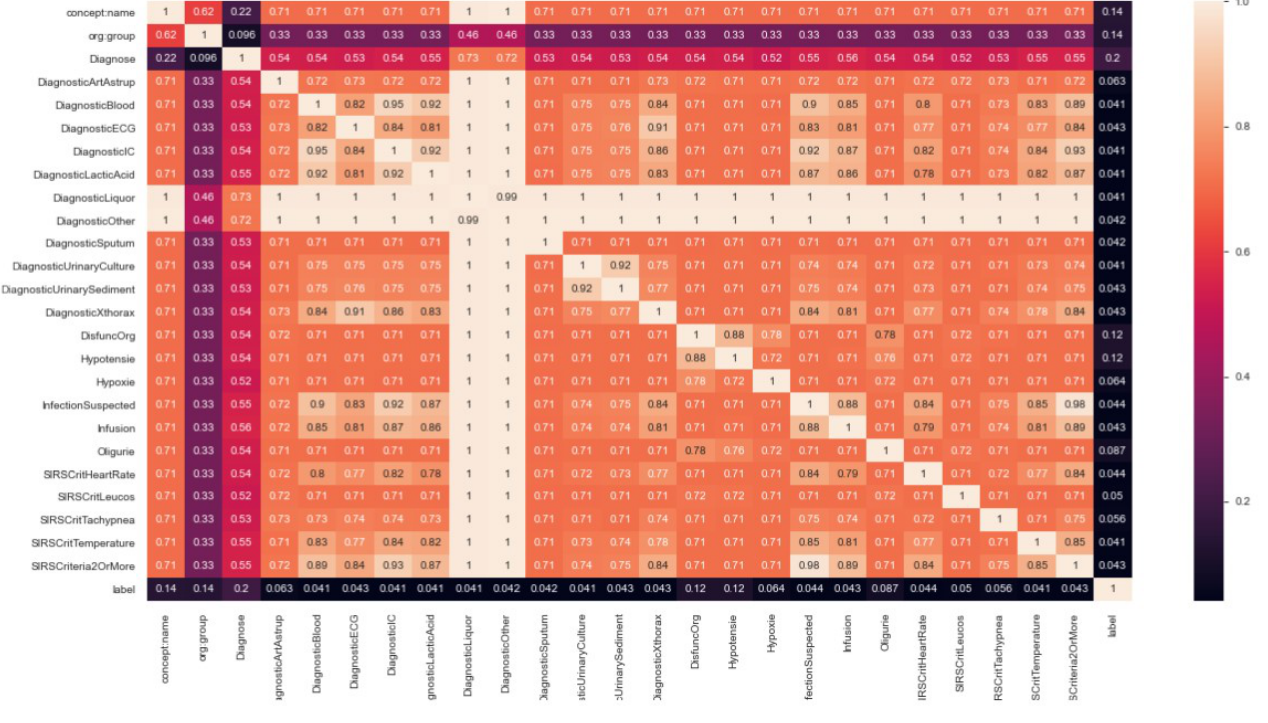
Figure 6. Collinearity between categorical attributes in Sepsis2